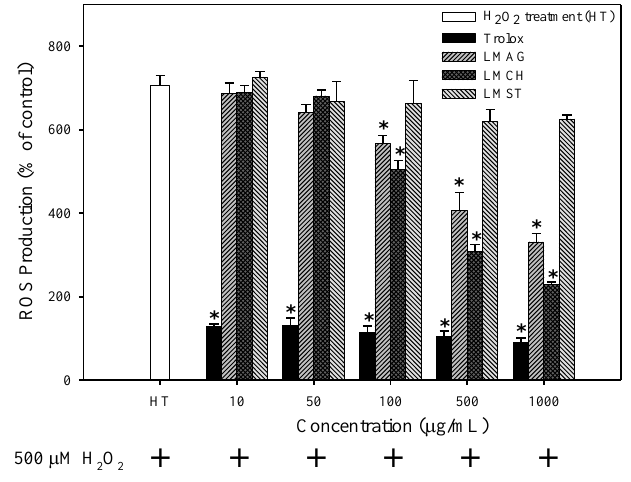
Figure 3. The effects of low-molecular-weight agar (LMAG), low-molecular-weight chitosan (LMCH), low-molecular-weight starch (LMST), and trolox on the production of intracellular reactive oxygen species (ROS) in Hs68 cells after 30 min treatment with 500 μM H O . Data are expressed as mean values ± S.D. of triplicate experiments. 2 2 * p < 0.05 (treatment vs . HT); HT = H O 2 2